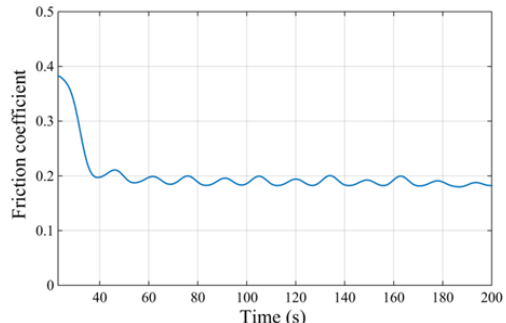
Figure 8. The friction coefficient curve.